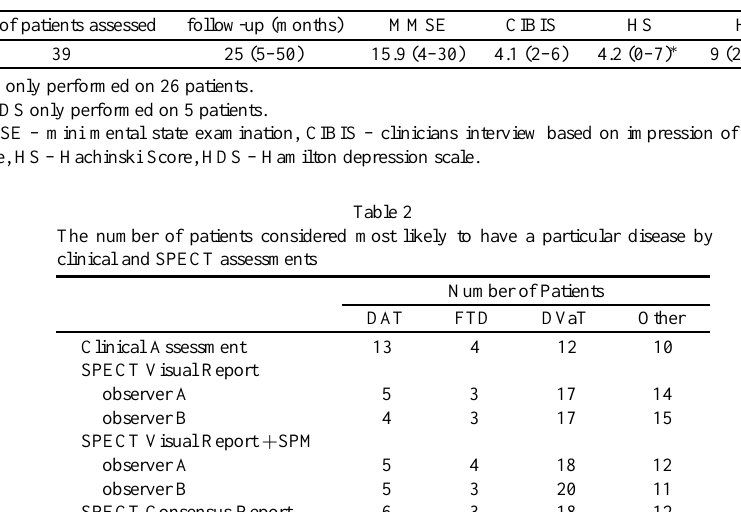
Table 1 Summary of overall assessment scores for 39 patients. All values shown are mean and range